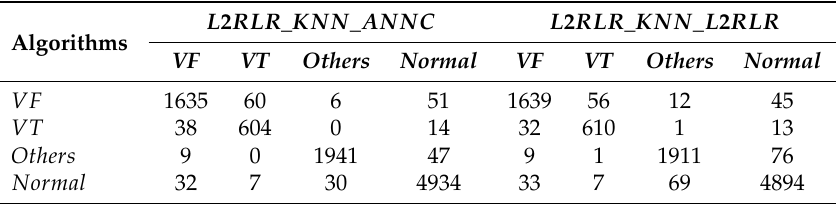
Confusion matrix for classification of VF , VT , Others , and Normal using